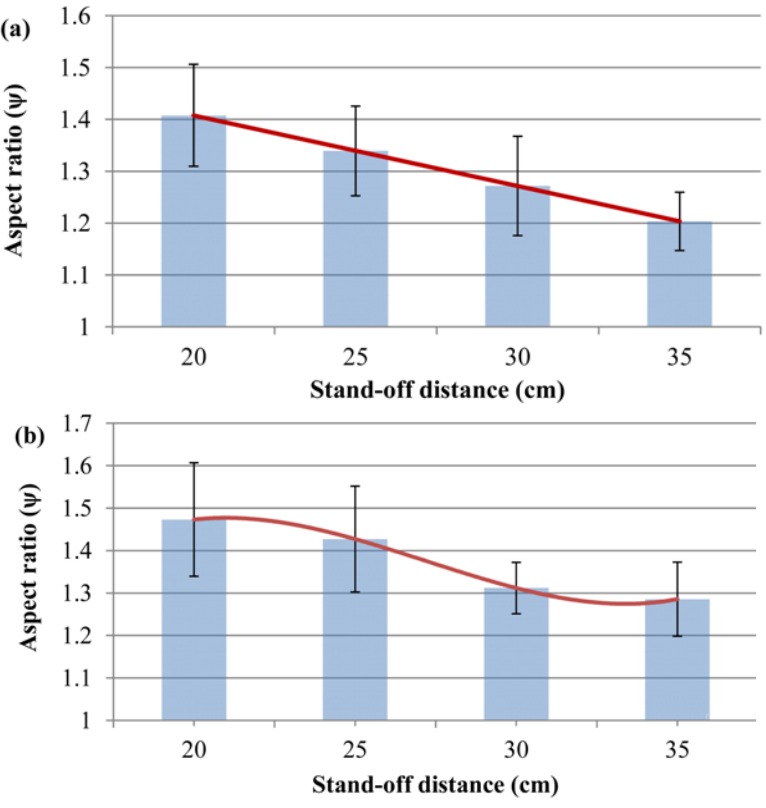
( a ) Glass and ( b ) Mild steel substrates.